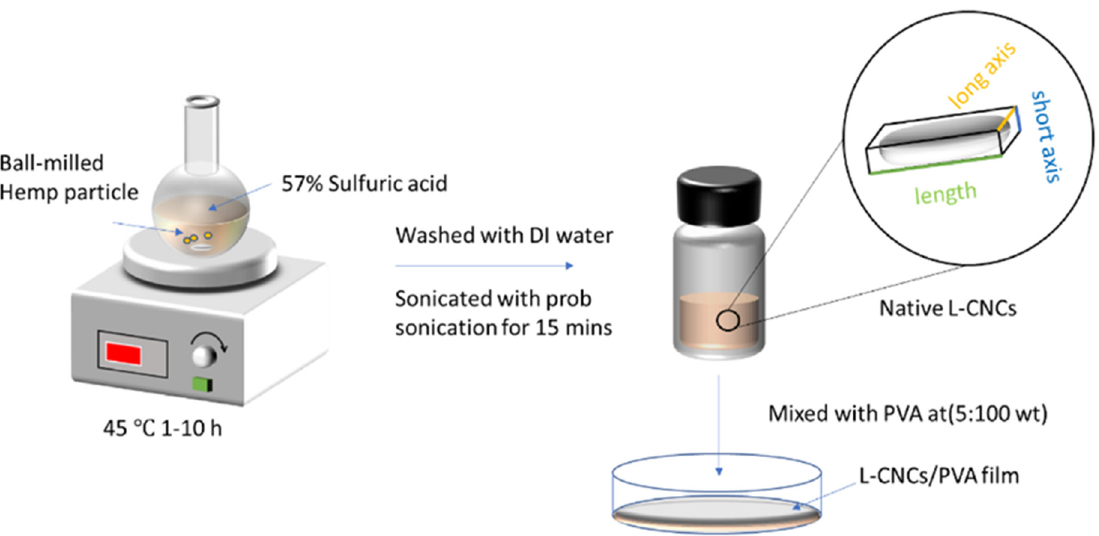
Figure 4. Schematic representation of solution casting (Reproduced with permission from Zhang et al. 2020 [42] ).